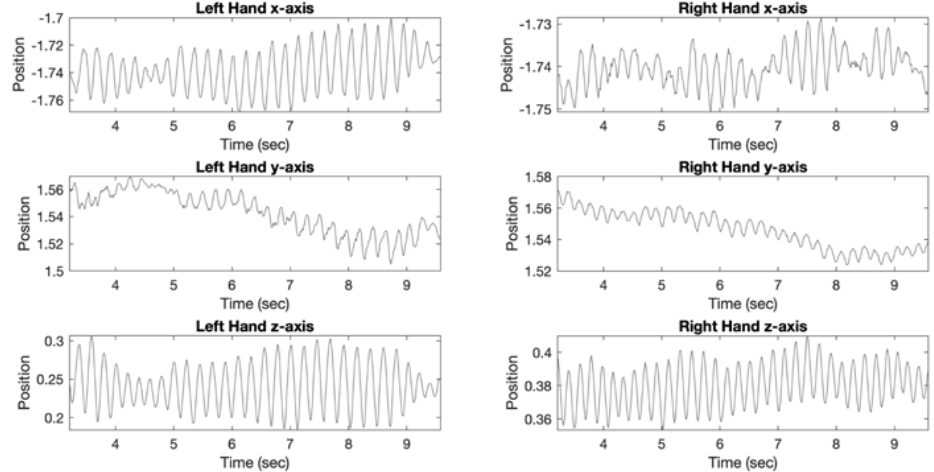
Figure 4. Plots demonstrating position ( x , y , and z axis) versus time for Posture VR tremor assessment in a 67-year-old right-handed female. Analysis of left upper extremity VR data demonstrated VR Posture Tremor Power of 7.26 × 10 − 4 m 2 /Hz and VR Posture Tremor Frequency of 4.7 Hz. Analysis of right upper extremity VR data demonstrated VR Posture Tremor Power of 1.26 × 10 − 4 m 2 /Hz and VR Posture Tremor Frequency of 5.4 Hz. MoCA score was 21 and UPDRS-III motor score was 21 with tremor sub-scores (UPDRS 3.15, 3.17, 3.18) ranging from 1 (slight) to 2 (moderate). Patient was not receiving medication for PD.